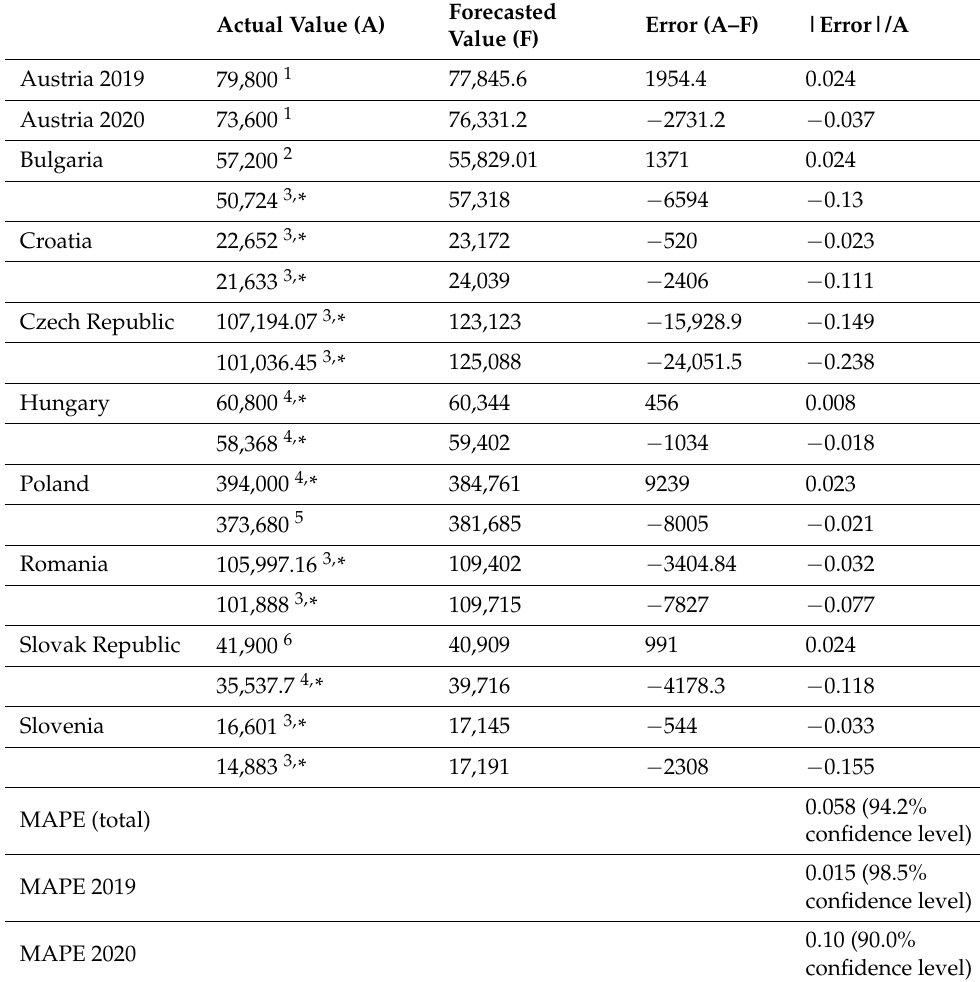
Table 6. Preliminary assessment of the forecasting performance for aggregated GHGs at the national level (2019 and